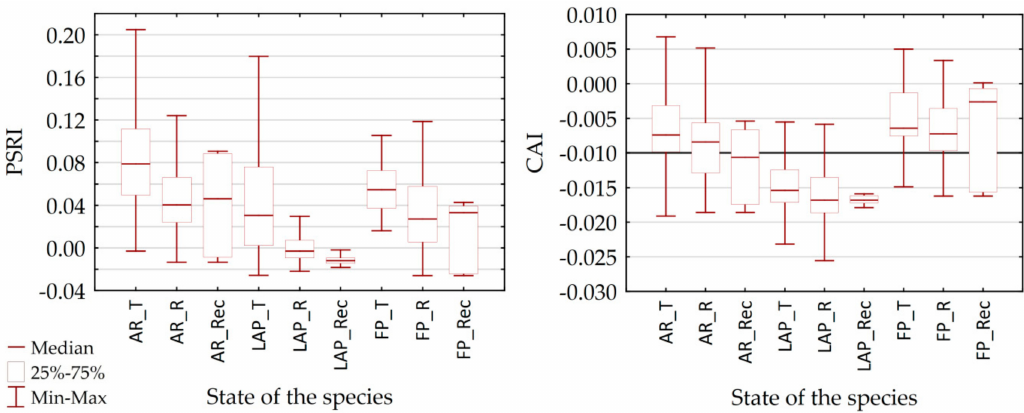
Figure 6. Values of indices: CAI (Cellulose Absorption Index) and PSRI (Plant Senescence Reflectance Index), n = 49,375 per species. Explanation: AR_T— Agrostis rupestris trampled, AR_R— Agrostis